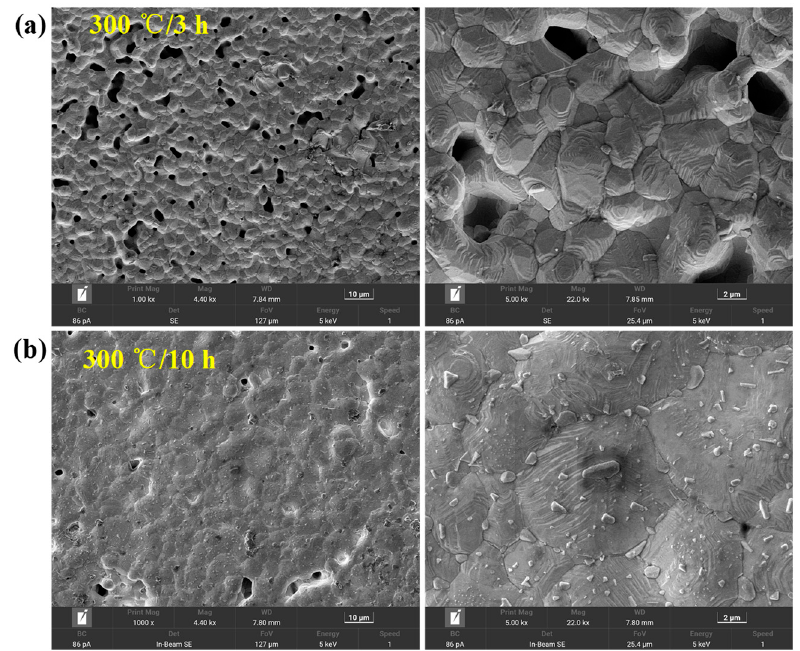
Figure 3. ( a ) SEM of a wireless LC conformal temperature sensor at 300 ◦ C for 3 h; ( b ) SEM of a wireless LC conformal temperature sensor at 300 ◦ C for 10